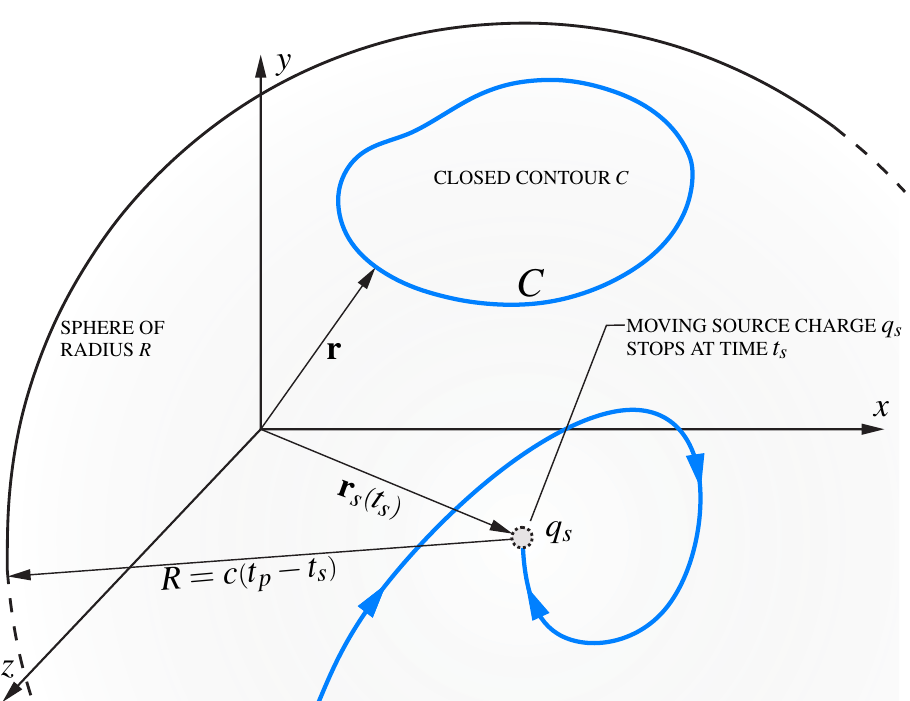
Figure 3. Source charge q s is moving along arbitrary trajectory r s ( t ) and it stops at past time t s . Closed contour C is at rest at all times. All the points r on contour C are inside the sphere of radius R = c ( t p t s ) . At present time t p > t s all the points on contour C are affected only by Coulomb’s − electrostatic